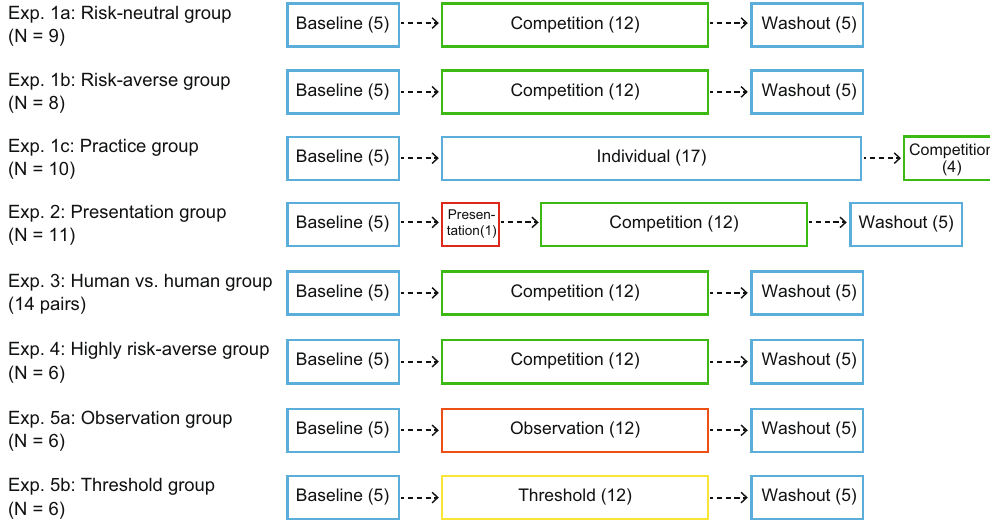
Figure 2. Experimental protocol for each experiment. The baseline, individual, and washout sessions comprised the individual task, whereas the competition session comprised the competitive task. The observation and threshold sessions comprised the observation and threshold tasks, respectively. Numbers in parentheses denote the number of experimental blocks conducted.